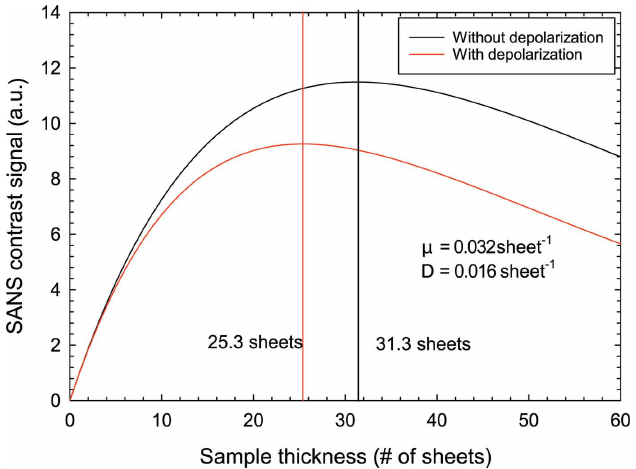
Figure 3 Simulation of the Vitroperm SANS contrast signal as a function of the sample thickness, with and without depolarization. For the comparison, the parameters determined by the transmission depolarization measure- ment at 17 mT are taken: (cid:2) = 0.032 sheet (cid:3) 1 and D = 0.016 sheet (cid:3) 1 . Considering the depolarization, the optimum thickness shifts from 1/ (cid:2) = 31.3 to 25.3 sheets.